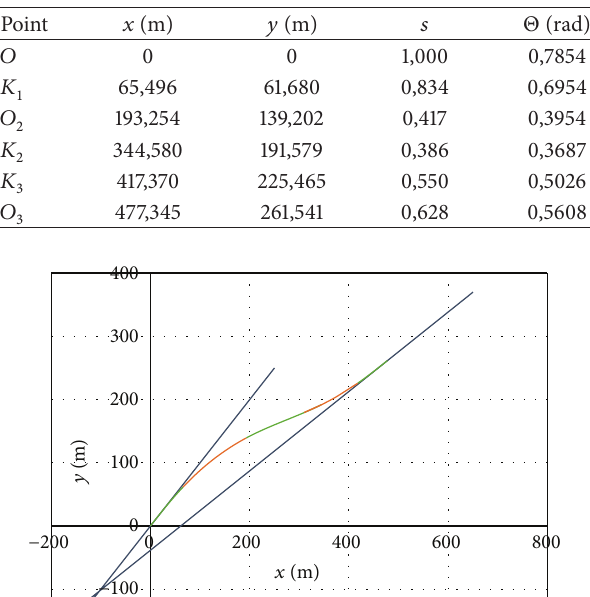
Table 1: Characteristic of the principal points of the geometric system (Example 1).